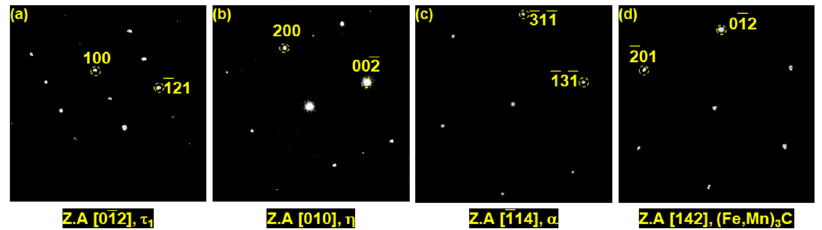
Figure 10. STEM results showing the of FIB specimen extracted from the area denoted by Y 1 in Figure 5. ( a ) HAADF Image, ( b – g ) results of EDS: ( b ) Al, ( c ) Ni, ( d ) Si ( e ) Fe, ( f ) Mn, and ( g ) C.